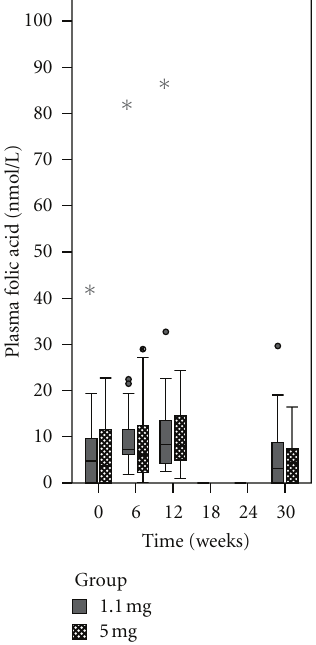
Figure 8: Plasma concentrations of unmetabolized folic acid among women who supplemented with 1.1mg of folic acid (grey boxes) compared to 5 mg of folic acid (cross-hatched boxes). When analyzed by group, the change in plasma folic acid concentrations was not significant in either the 1.1 mg ( P = 0 . 20) or 5mg ( P = 0 . 10) group.